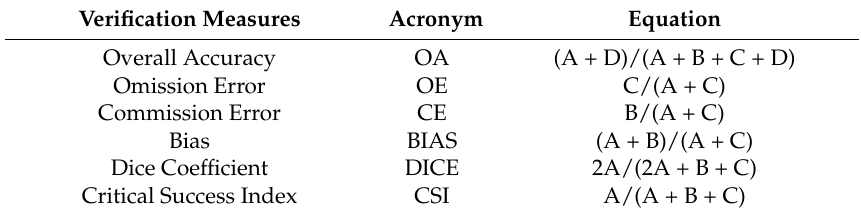
Table 3. Verification measures, acronyms and equations derived from contingency table from Table